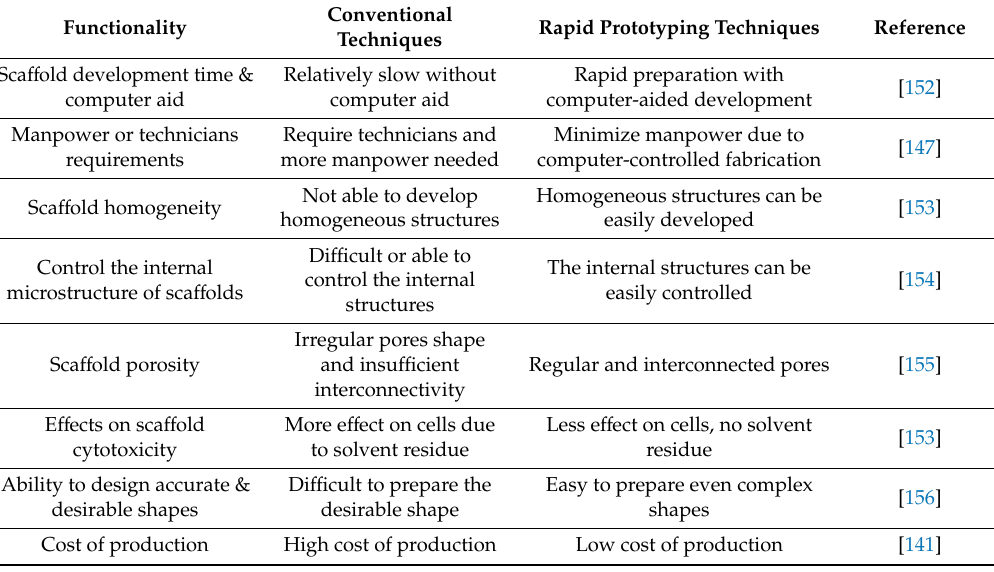
Table 7. Comparison between conventional and rapid prototyping techniques for sca ff old